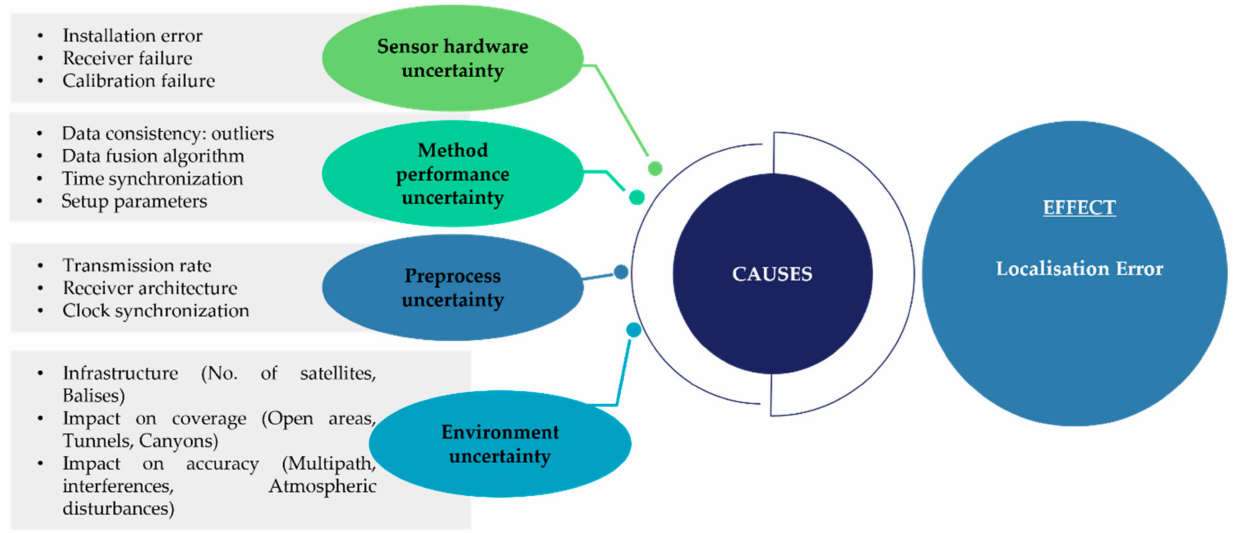
Figure 8. Fishbone diagram showing factors contributing to location